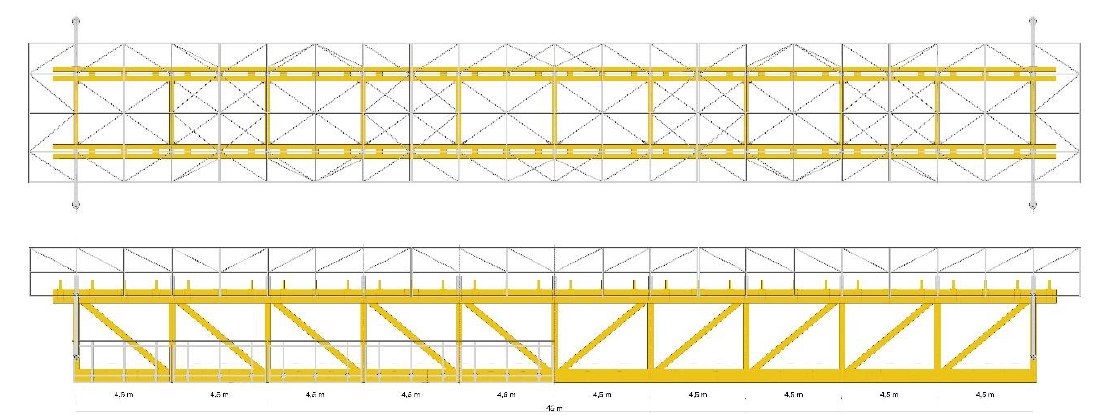
Figure 8. Structural system of the timber bridge over the Gravina torrent. Table 1. Mechanical properties of materials (GL24h, GL28h, GL32h: Glued Laminated Timber grades; f t, 0 ,k : characteristic tension strength parallel the grain; f c, 0, k : characteristic compression strength parallel the grain; S275H: Steel Grade according to UNI EN 10210-1; S355: Steel Grade according to UNI EN 10025-2; f yk : characteristic yield strength; f tk : characteristic failure strength; E : Young’s modulus; specific weight).